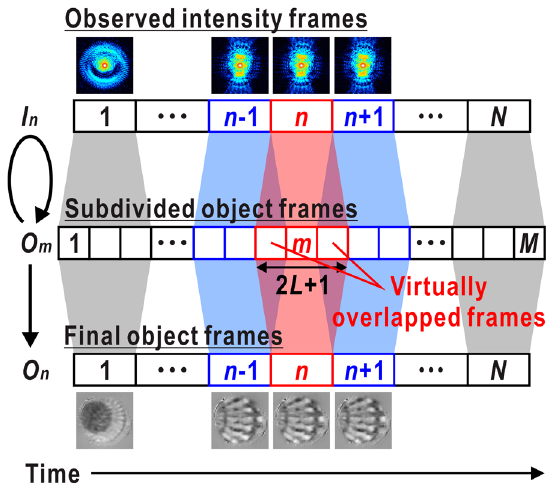
Fig. 3 Temporal discretisation scheme of diffraction intensity and object dynamics in multiple-frame ptychographic iterative engine algorithm. Correspondence among the observed intensity frames I n , numerically subdivided object frames O m , and actual object frames O n are illustrated. The number of the overlapped frames in the temporal domain L ¼